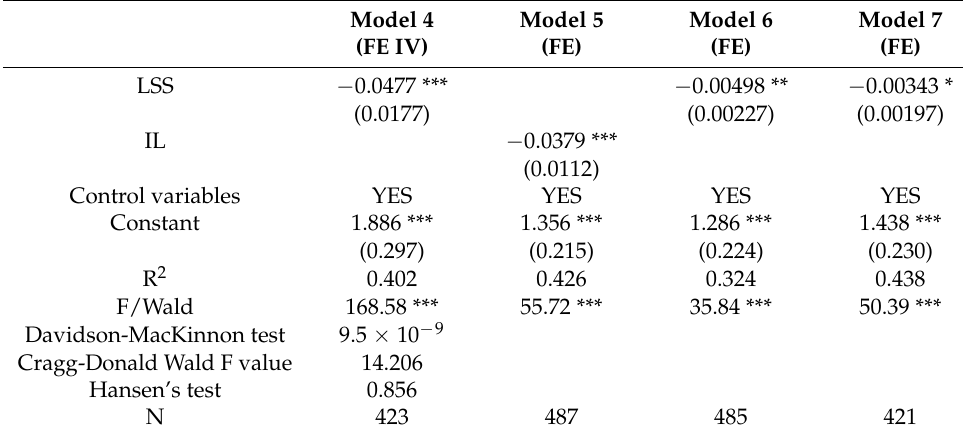
Table 4. Robustness